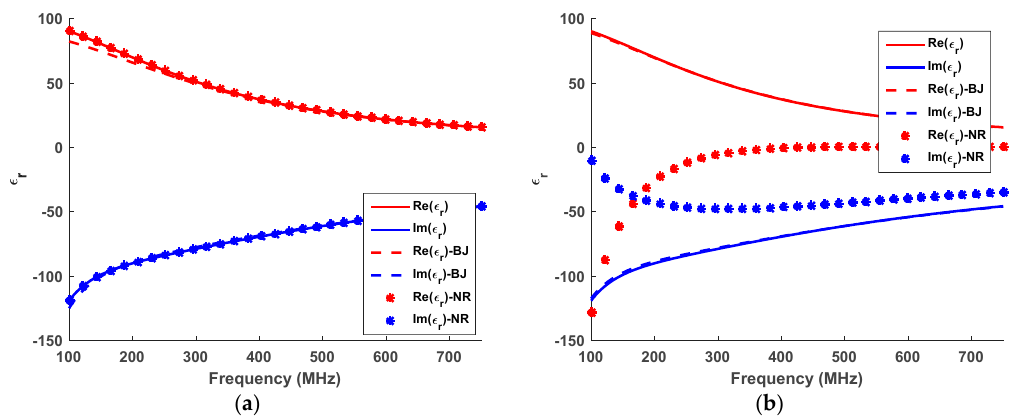
thus providing an accurate estimation of the real and imaginary part of the dielectric permittivity.